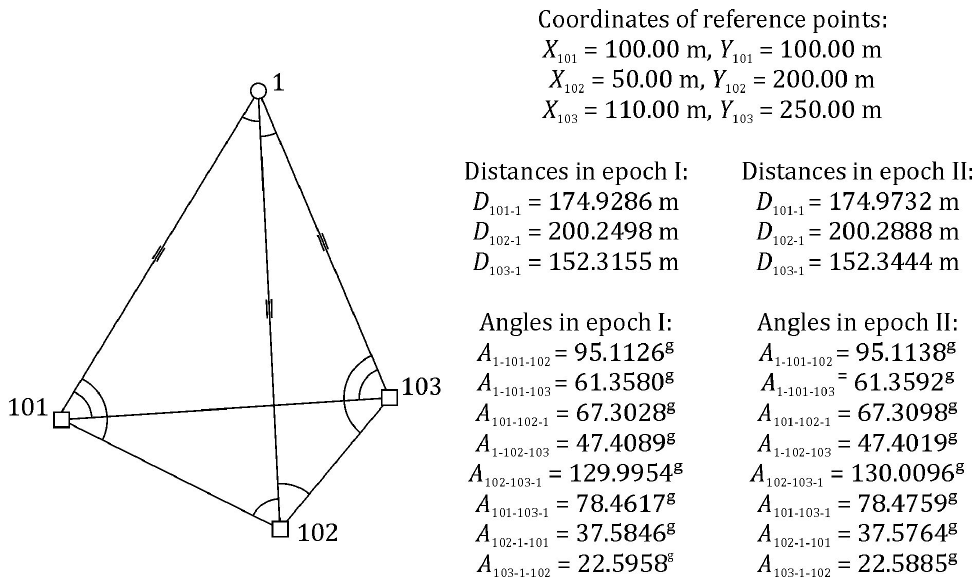
Fig. 1. Simulated horizontal network Table 4. Empirical significance levels α emp